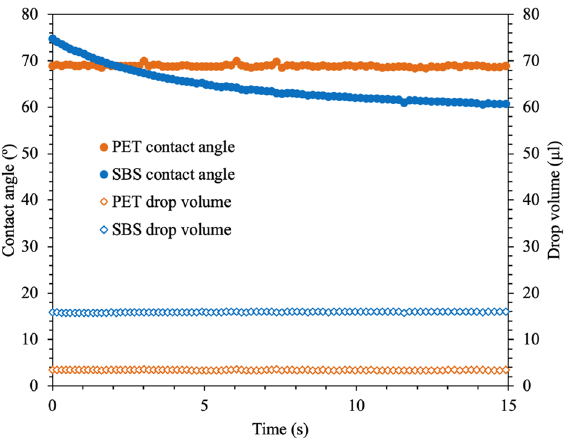
Figure 4. Contact angle of water on PET and SBS substrates over time.